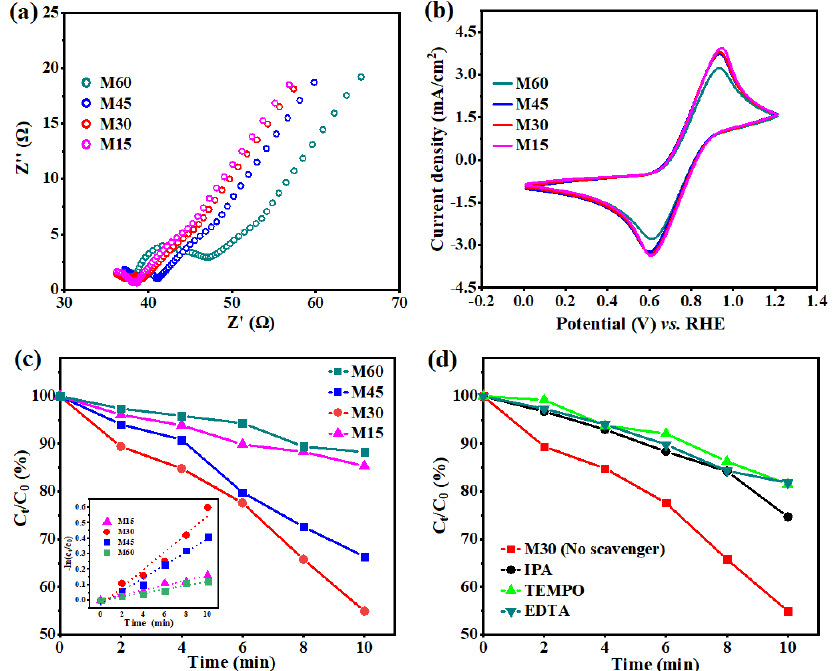
Figure 6. ( a ) EIS Nyquist plots and ( b ) CV curves for the M15-M60; ( c ) TCH degradation and (inset) kinetic curves of TCH degradation for the M15-M60; ( d ) TCH degradation for the M30 with different scavengers. Table 1. Comparative PEC degradation results of BiVO 4 -based and BDD-based heterojunction photoanodes in recent